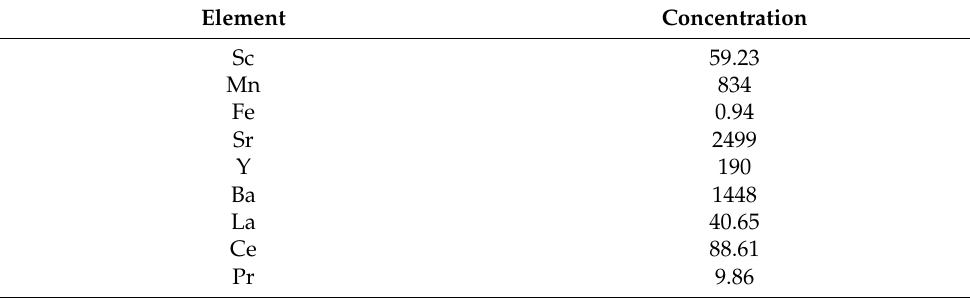
Table 1. Average whole-bone trace element composition of the left tibia of Brachylophosaurus canadensis MOR 2598. Numbers presented are averages of all transect data acquired across the cortex. Iron (Fe) is presented in weight percent (wt. %); all other elements are in parts per million (ppm). Absence of (Ce/Ce*) N , (Pr/Pr*) N , (Ce/Ce**) N , and (La/La*) N anomalies occurs at 1.0, and these anomalies were calculated as in the Materials and Methods. The Y/Ho value reflects this mass ratio. Element Concentration Sc